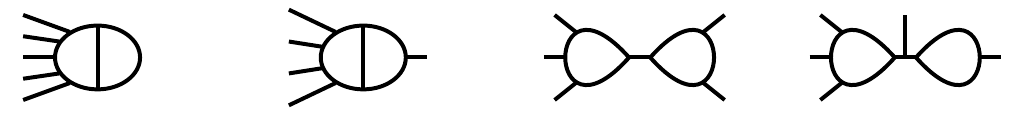
Figure 3 . All maximal degeneration graphs of class (1), namely containing no subgraphs with one, two, or three external edges..